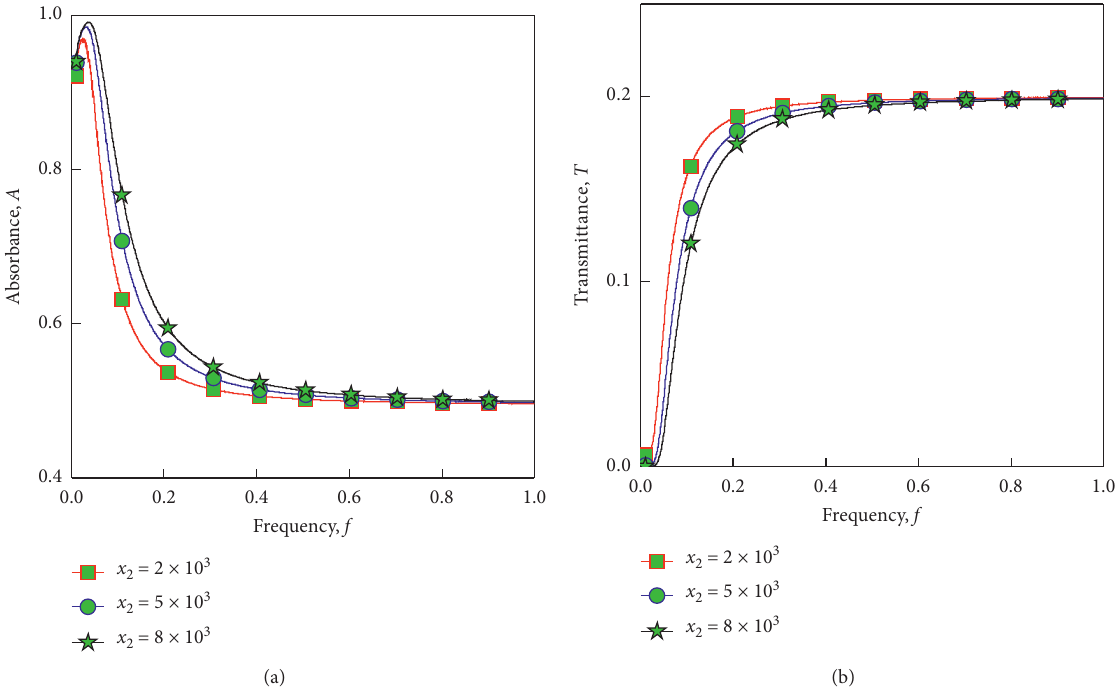
Figure 5: Absorbance and transmittance versus wave frequency for different steepness coefficients of the electron density in a dusty plasma